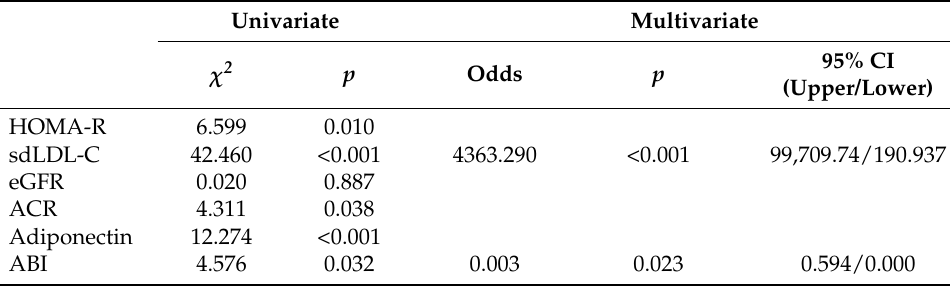
Table 4. Logistic regression analysis for the factors for lower or higher RemL-C levels in all subjects with T2DM.